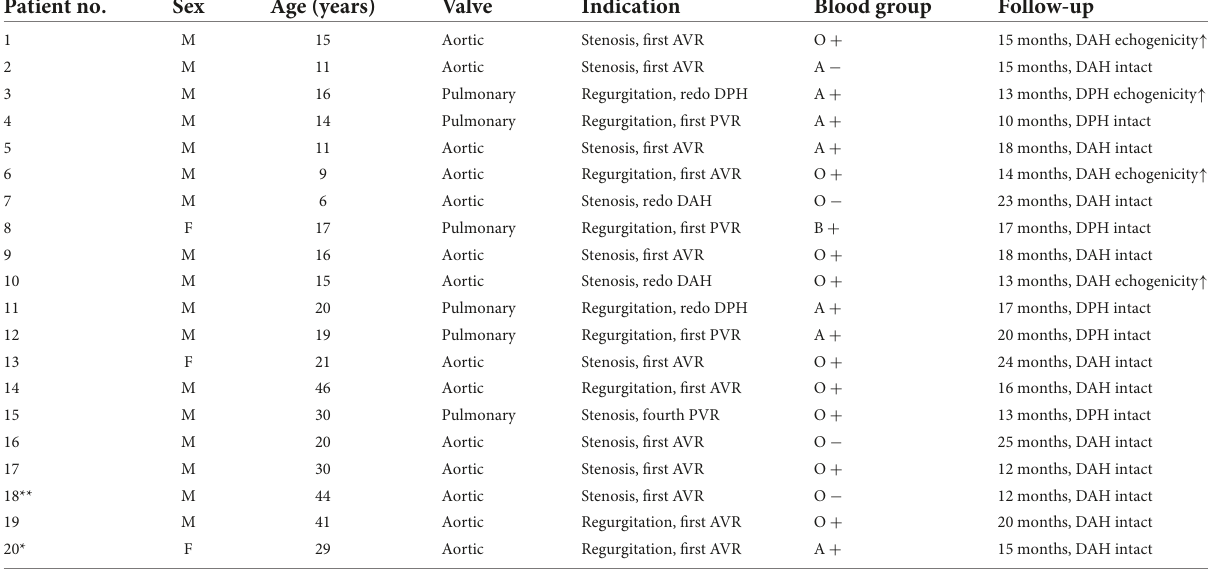
TABLE 1 Patient cohort characteristics. Patient